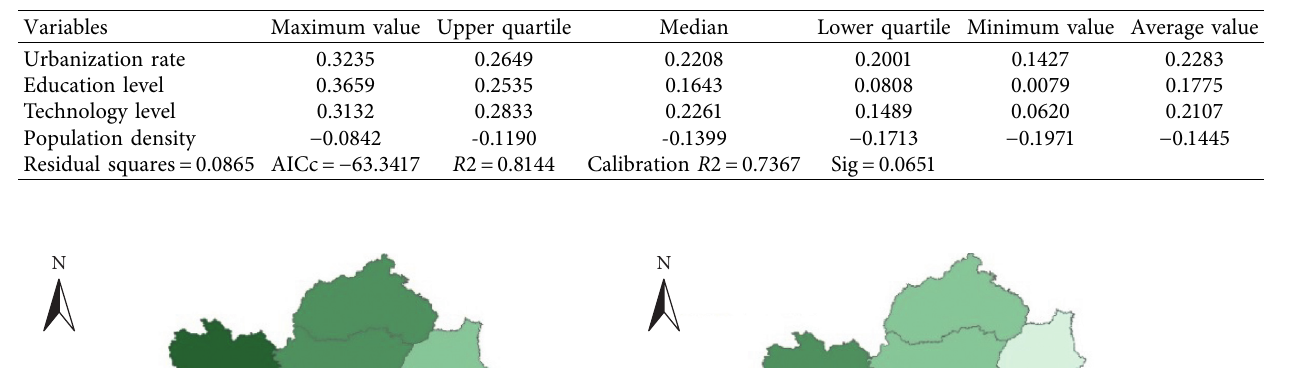
Table 7: Results of GWR model